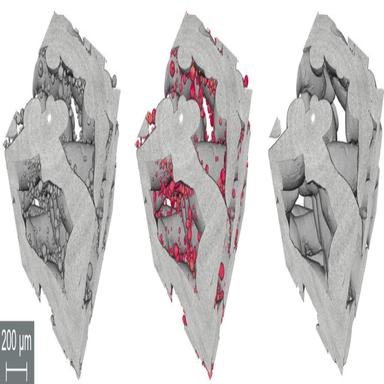
3D rendering of the original "raw" dataset (left) with highlighted powder particles (center) and the filtered structure's surface (right) of sample 4. The bottom row shows a magnification of a cubic cut of the volume renderings seen in the upper row.